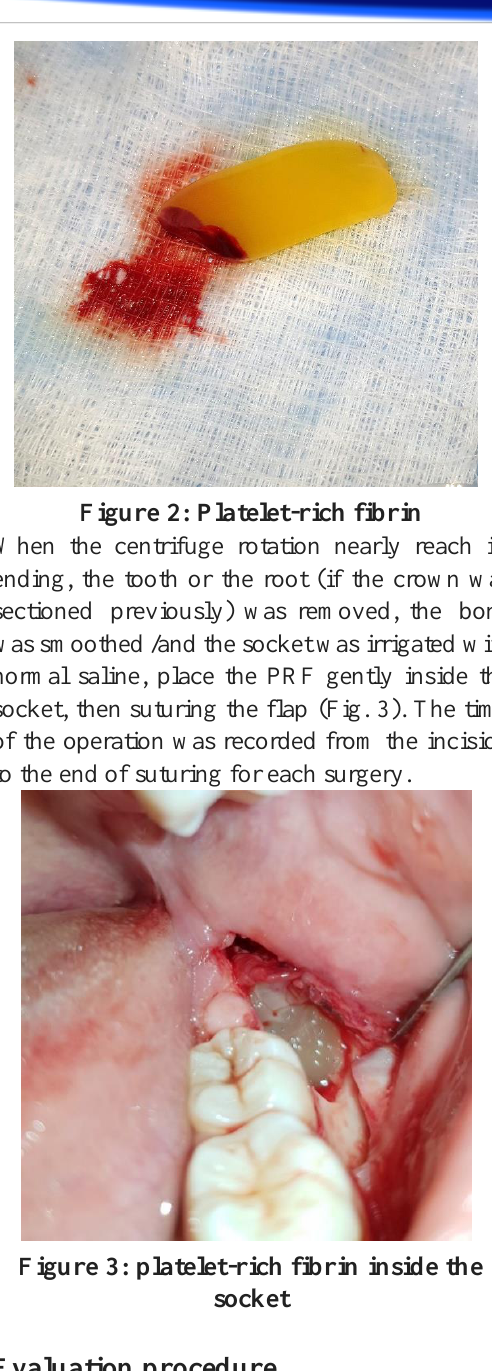
Figure 3: platelet-rich fibrin inside the